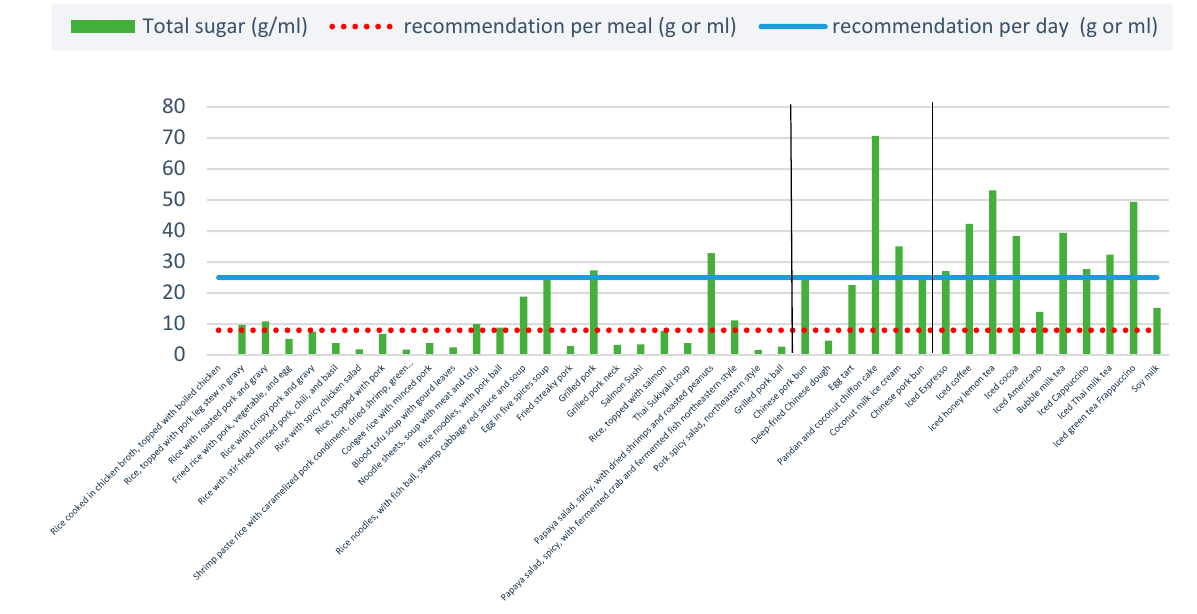
Figure 5. Total sugar content per portion of 40 menu items. Note: Two vertical blacks line separate